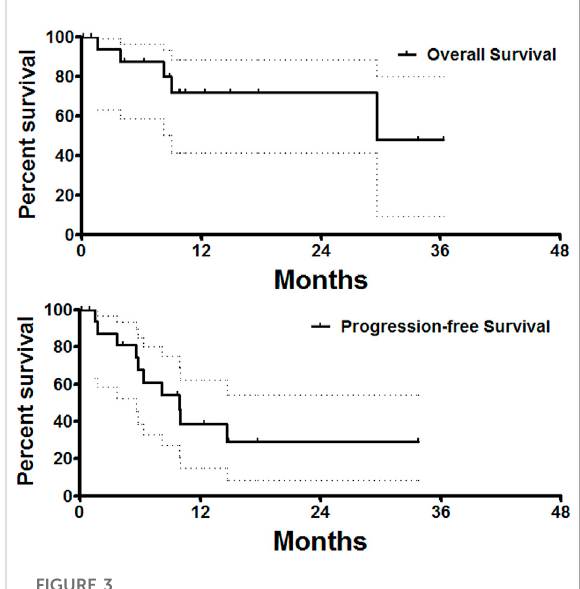
FIGURE 3 Survival follow-up. The median PFS and median overall survival was 9.9 and 29.6 months,